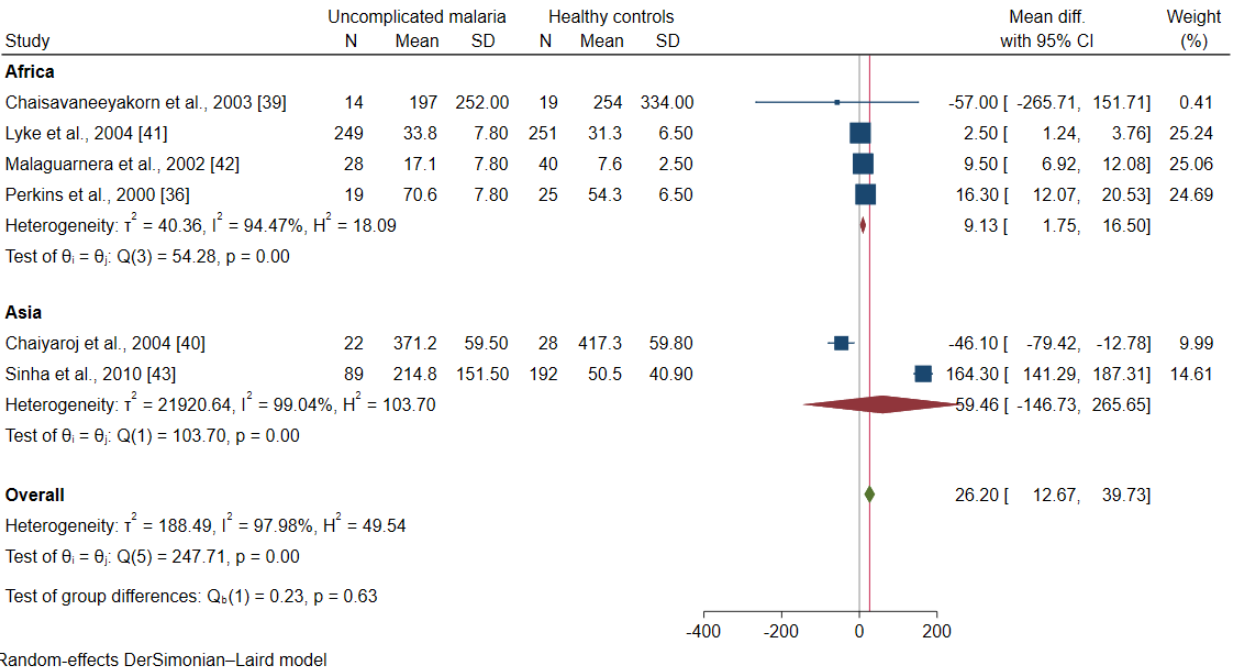
Figure 6. Forrest plot demonstrated the difference in the mean IL-12 levels (pg/mL) between patients with uncomplicated malaria and healthy controls by continents [36,39–43]. Abbreviation: Mean Diff., mean difference; CI, confidence interval. Explanation of the forest plot: squared-box symbol, point estimate; green diamond and red line: pooled mean difference: red diamond: pooled mean difference in each subgroup; blue line: line of no effect; I 2 , level of heterogeneity; p = 0.00 or less than 0.05, significant heterogeneity.